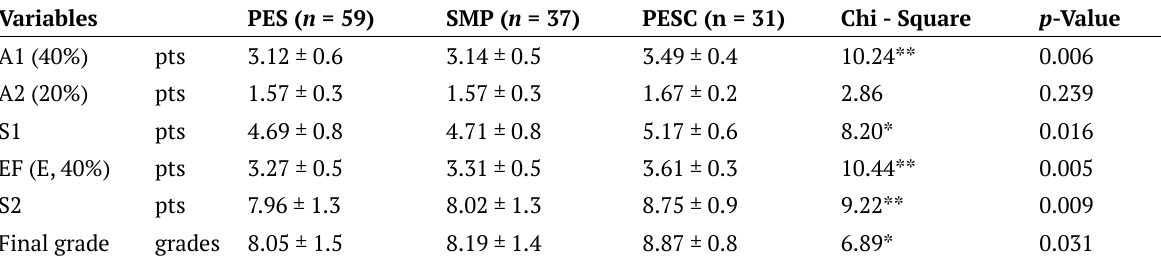
Figure 1. Weight of the sports branch selection by the subjects participating in the study. PES - Physical Education and Sport; SMP - Sport and Motor Performance; PESC - Physical Education and Sport Conversion; 1 – Football; 2 – Tennis; 3 – Karate; 4 – Basketball; 5 – Athletics; 6 – Handball; 7 – Fitness; 8 – Swimming; 9 – Wrestling; 10 – Volleyball; 11 – Theory knowledge; 12 - Skiing; 13 – Sledge; 14 – Judo; 15 – Kayac; 16 – Canoe; 17 - Football-tennis; 18 – Bodybuilding; 19 – Skating; 20 - Artistic gymnastics; 21 – Fencing; 22 - Taekwon-do ITF. Table 2. Results of the evaluation of the basic fundamental knowledge in Kinesiology, n =